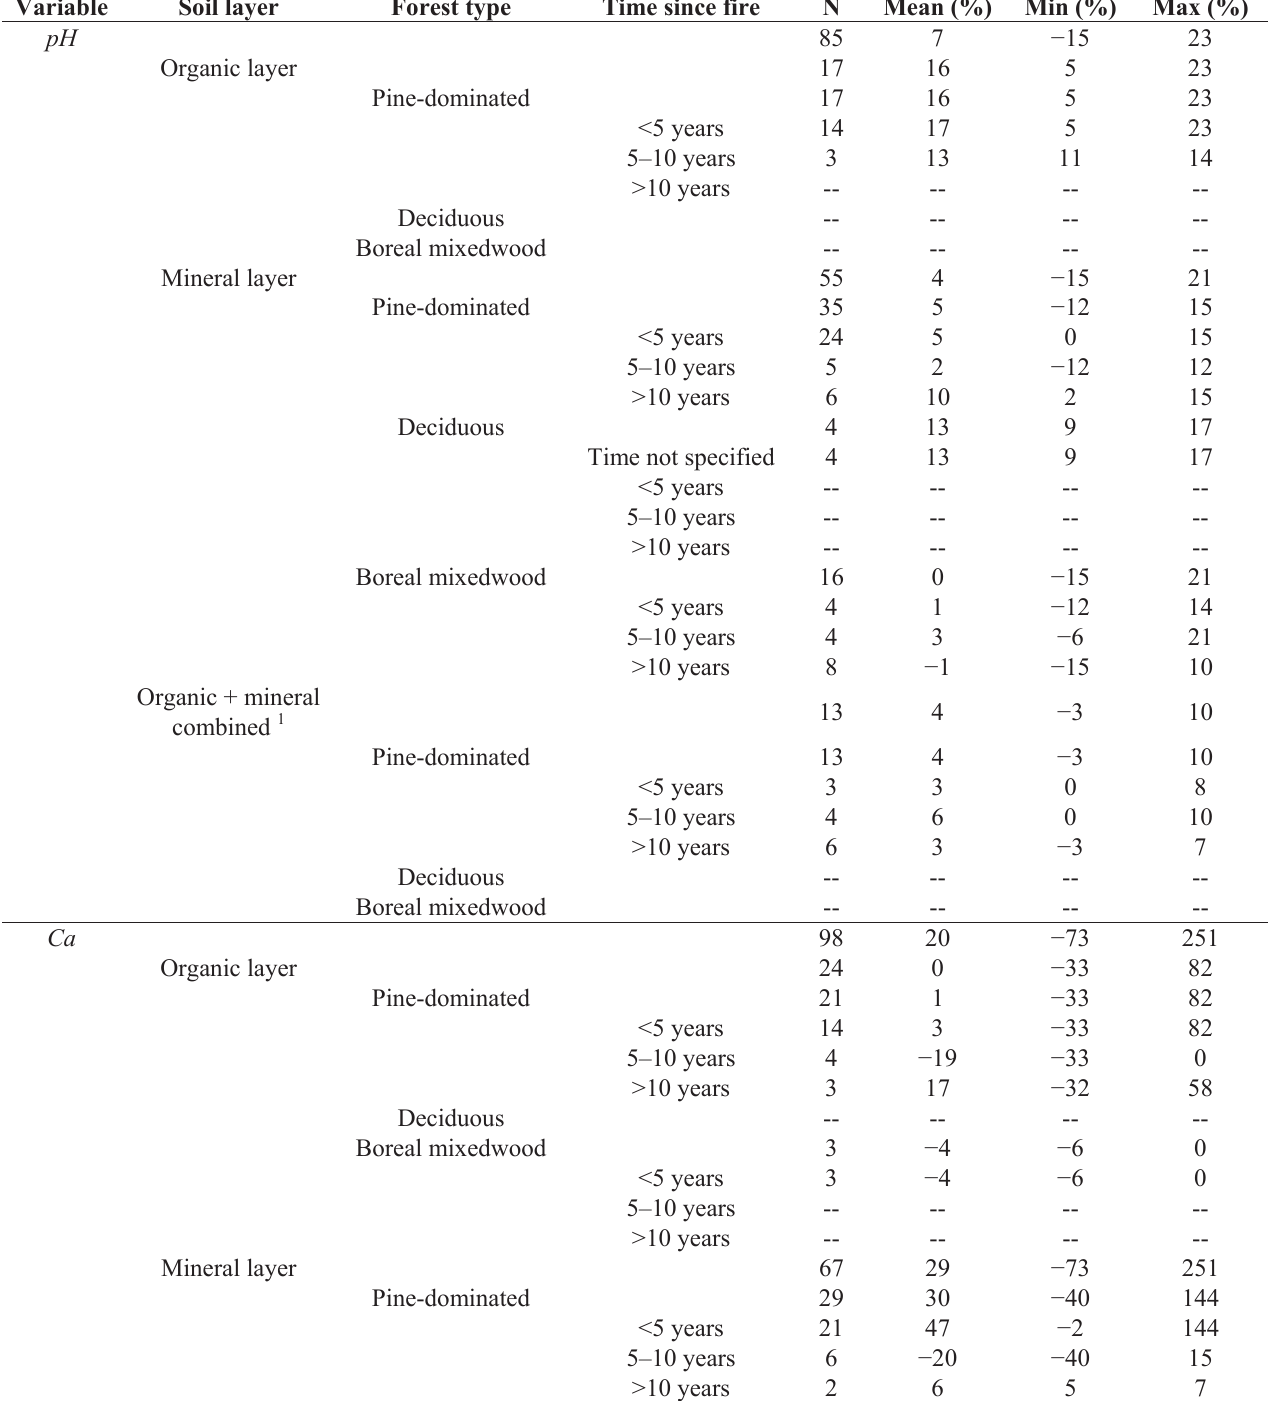
Table 4. Size and direction of fire effect on soil pH, Ca, K and Mg in Lake States forests by soil layer, forest type, and time since fire. Shown are number of observations in the literature that reported measurements from burned and reference (unburned) areas, and mean, minimum and maximum percent change relative to reference areas. Categories for which no data were reported for burned and reference areas are indicated by --. Values shown in rows for each variable, soil layer, and forest type major categories were calculated across all included